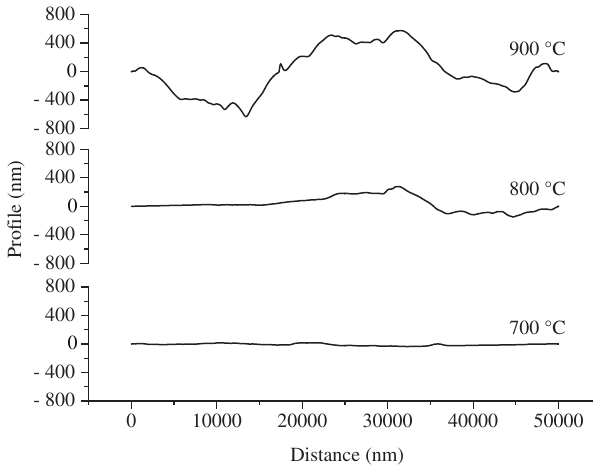
Figure 2. Surface profiles for the titanium samples nitrided at 80%N atmosphere and different temperatures.